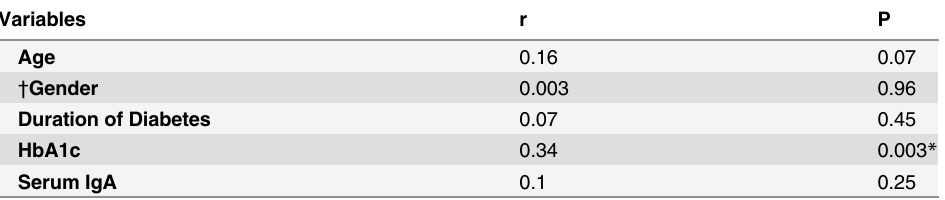
Table 3. Correlation coefficient between salivary IgA and other Variables in diabetic individuals.